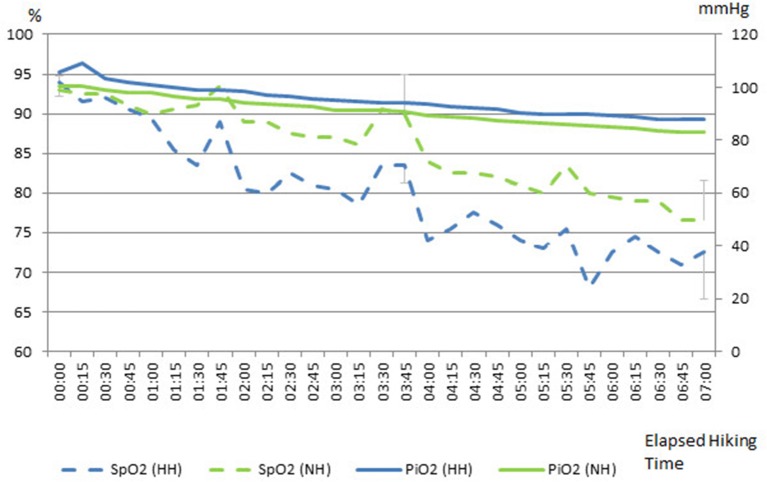
Comparison of inspired oxygen (PiO2) and peripheral oxygen saturation (SpO2) during the hikes in normobaric hypoxia (NH) and hypobaric hypoxia (HH). Legend: Break 1 at 3,100 m altitude, Break 2 at 3,500 m altitude, Break 3 at 3,900 m altitude; % = SpO2%; mmHg = PiO2 mmHg.